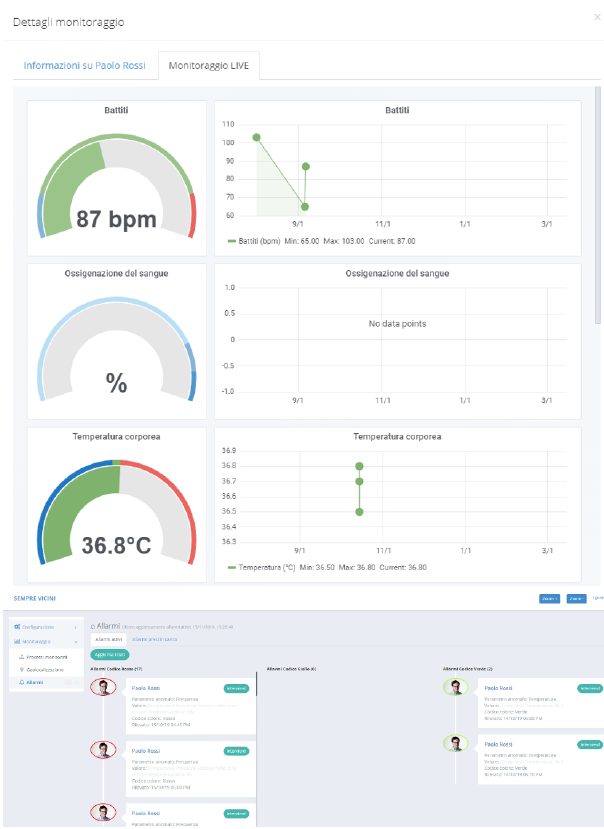
Figure 4. Some screenshots of the application of the Assisto eCare 4.0 control room (interface is in Italian).